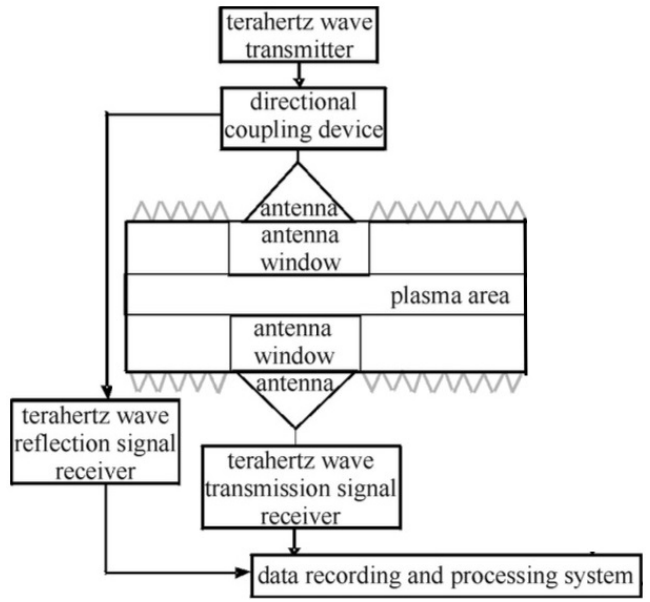
Figure 2. The schematic diagram of THz wave transmission attenuation in the plasma measure- ment